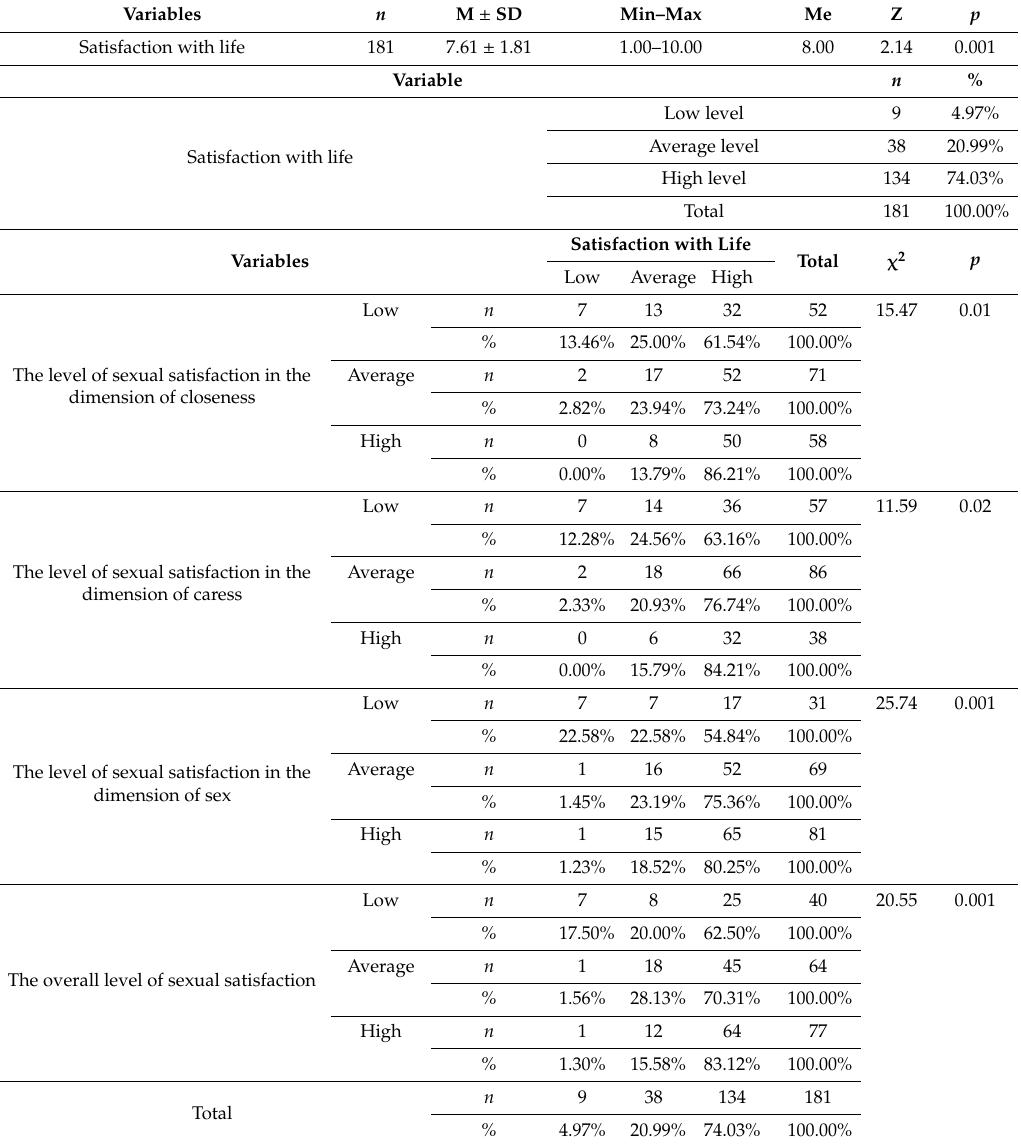
Table 6. The level of life satisfaction and the level of sexual